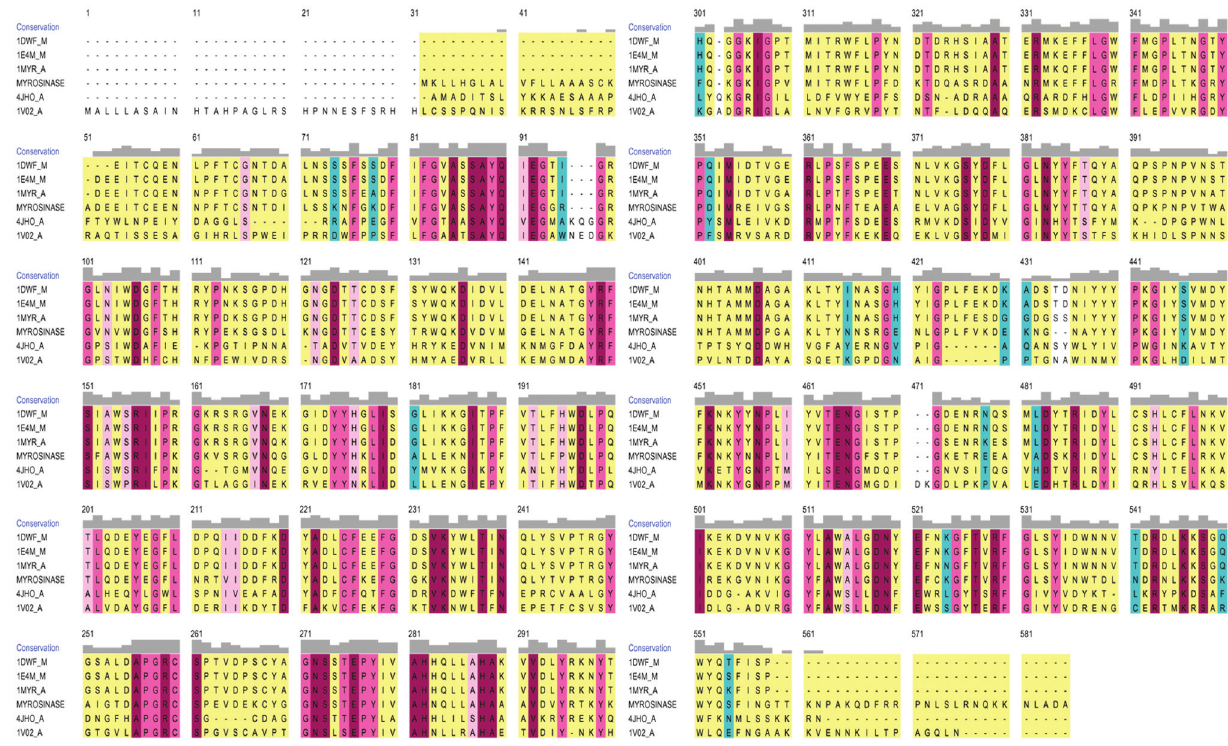
Figure 1. Sequence alignment of myrosinase with their template structures generated by using Chimera visualization tool. Gaps and conservation residues were denoted in dotted lines and gray color, respectively. In addition, block levels represented as identical (tallest blocks), conserved (Intermediate blocks) and mild conserved (Small blocks) and not identical (no